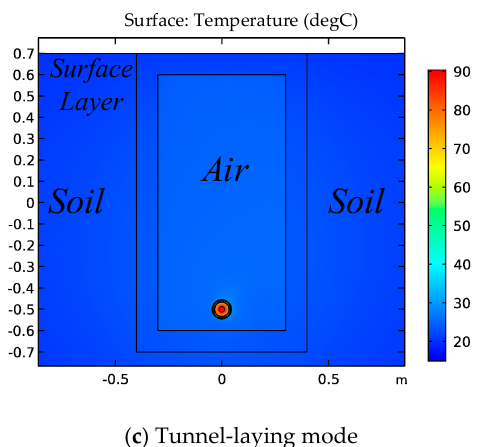
Figure 3. Schematic diagrams of the structural models of three different laying modes based on Comsol Multiphysics.